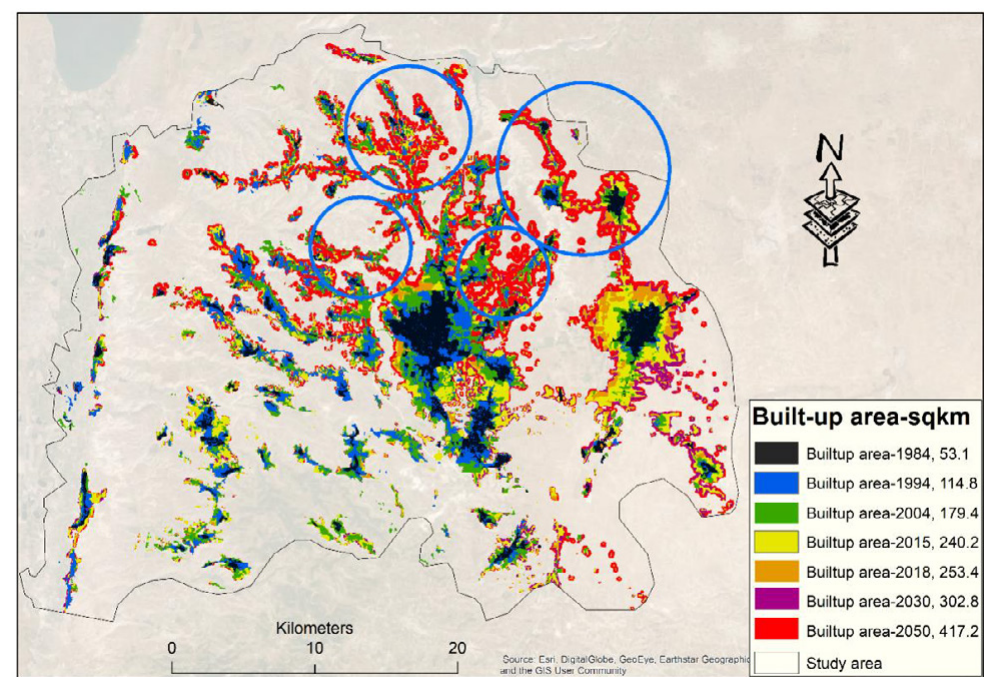
Fig. 5: Development of built-up area in Irbid governorate from 1984 to 2050 Table 9: Summary of Kappa indices for model validation Maps used for simulation Maps used for validation Degree of